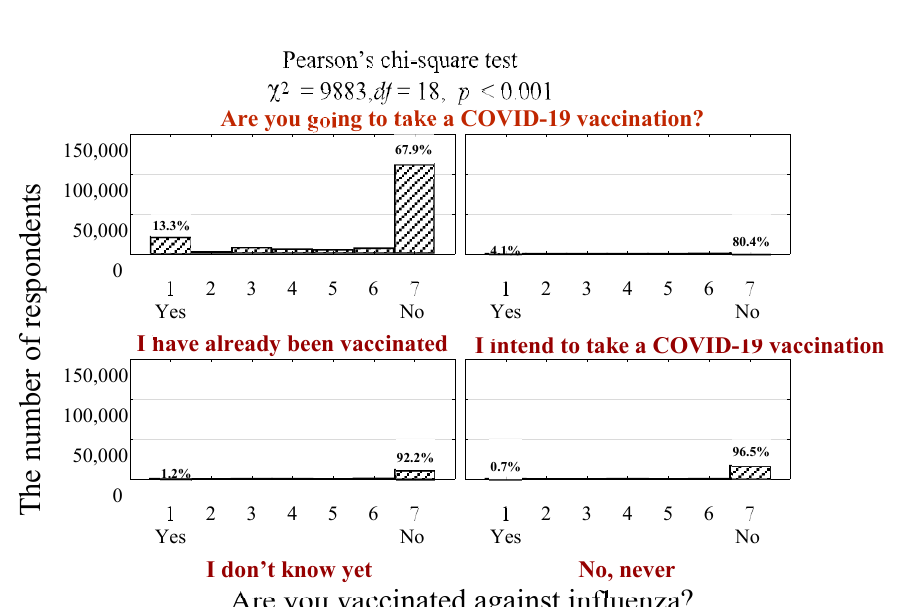
Figure 2. Number (percentage) of respondents answering differently to questions about COVID-19 and influenza vaccination.